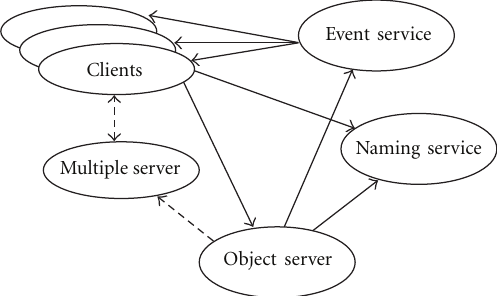
Figure 5: The underlying principle of multiple clients and servers.